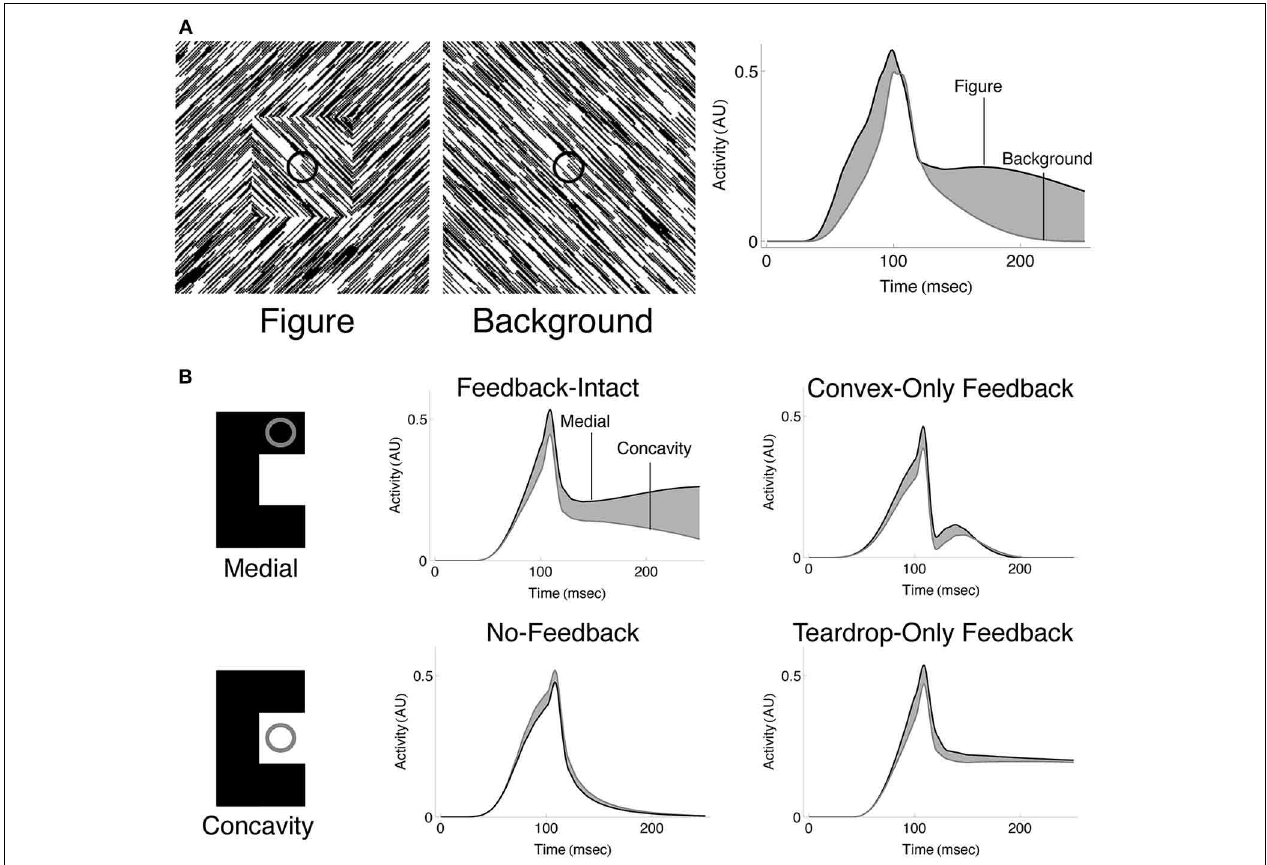
FIGURE 9 | Spatio-temporal dynamics of the model. (A) Convex cells demonstrate interior enhancement similar to single cells in primate area V1 (compare with Figure 1A ). We presented the model with a textured display that either contained a square figure (left panel) or just the background (middle panel). The square subtended the same size as that simulated in Figure 7A . The dynamics of the convex cell whose RF is centered on the square when it was present are shown on the right panel. The response of the convex cell is larger in the presence of the figure (black curve) than when just the background was present (gray curve). (B) Interior enhancement along the medial axis of a figure occurs due to feedback in the model. We presented the C-shape used in Figure 7B and plotted the dynamics of convex cells whose RFs were